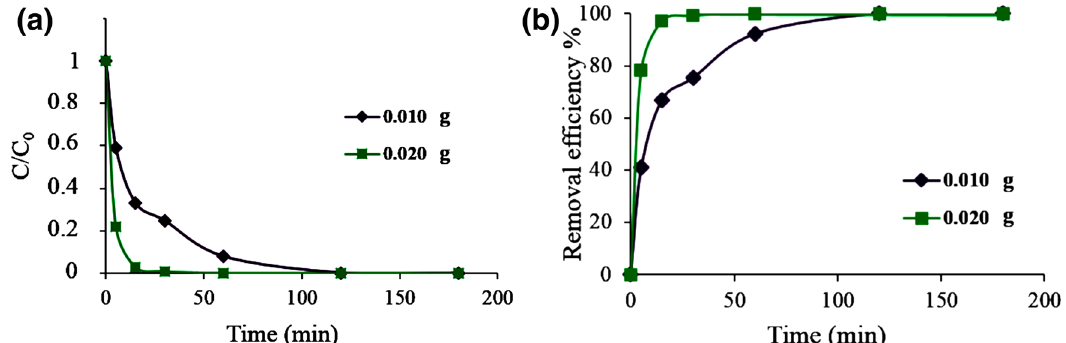
Figure 10. The effect of adsorbent dosage on the adsorption of AG-25 by Ch-rGO/Fe 3 O 4 . Experimental conditions: dye concentration 0.1 mg mL −1 , RT, and pH =